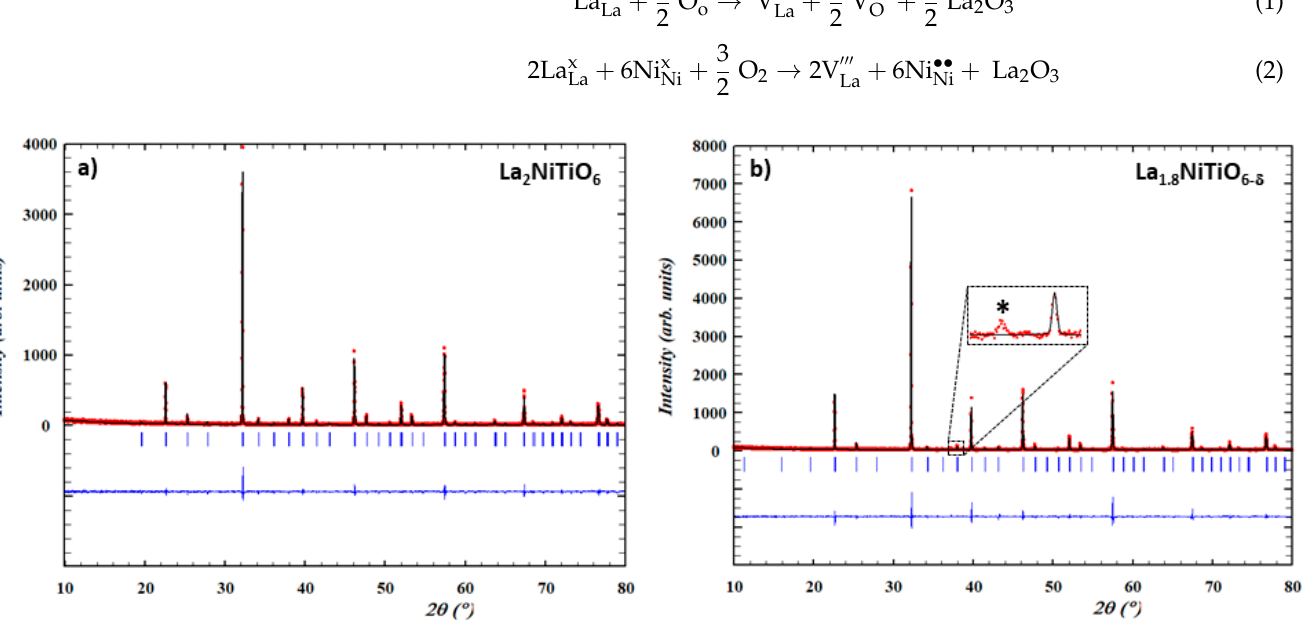
Figure 1. Experimental (red circles), calculated (black continuous line), their difference (blue line) and Bragg peaks position (blue vertical bars) for XRD patterns of as prepared ( a ) La 2 NiTiO 6 and ( b ) La 1.8 NiTiO 6 −δ at 1773 K for 24 h in air.